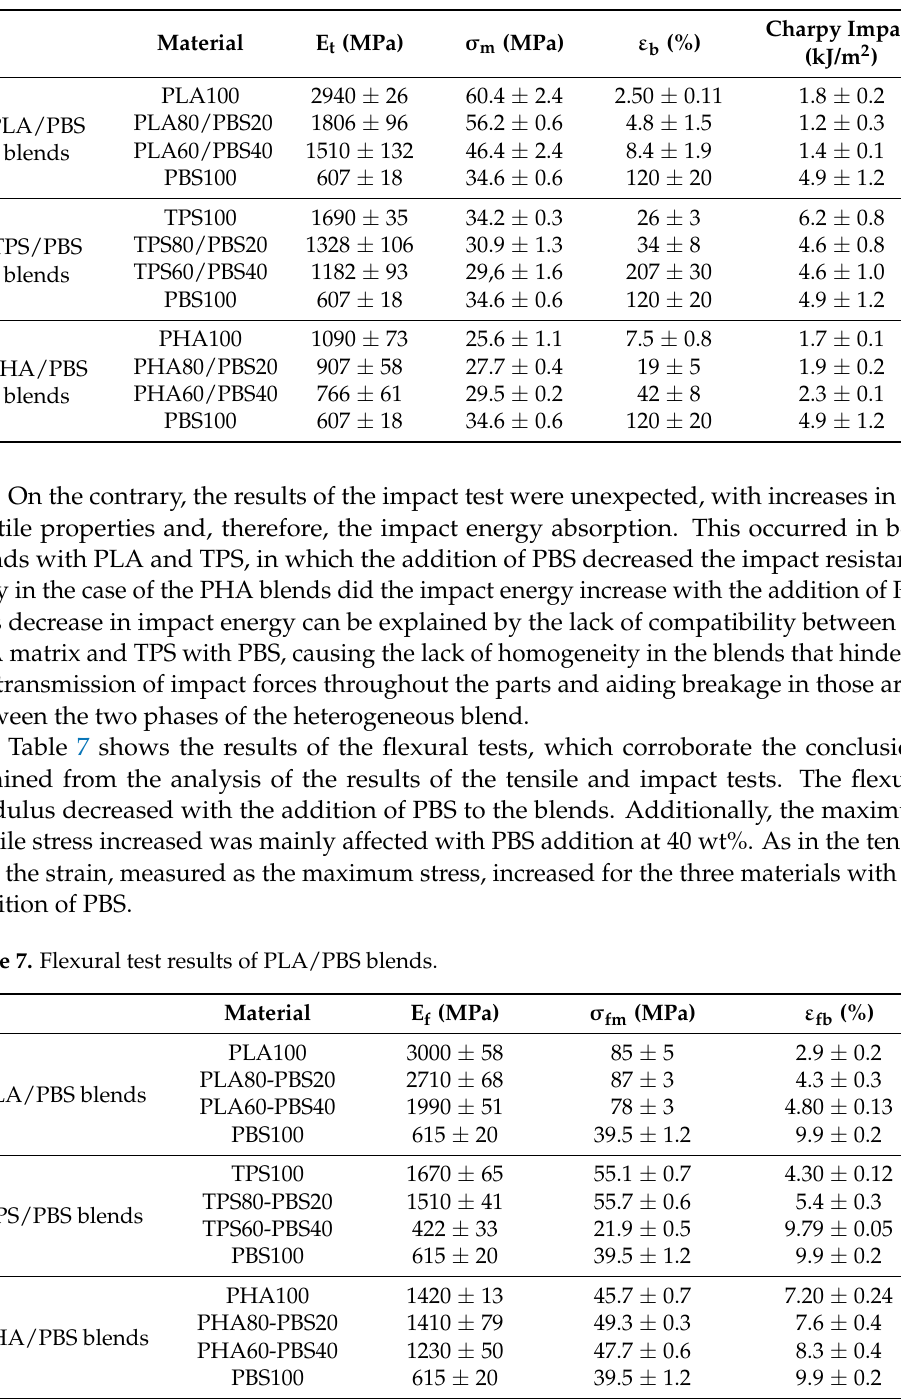
Table 6. Tensile test and Charpy tests results of PLA/PBS blends.